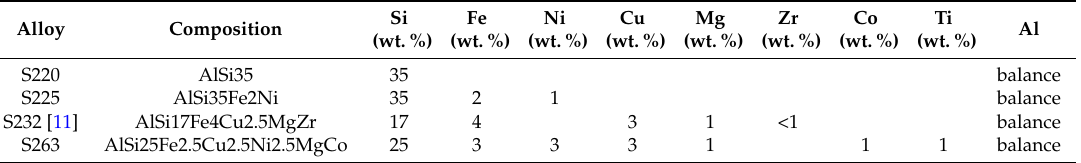
Table 1. Composition of DISPAL-alloys used for laser welding